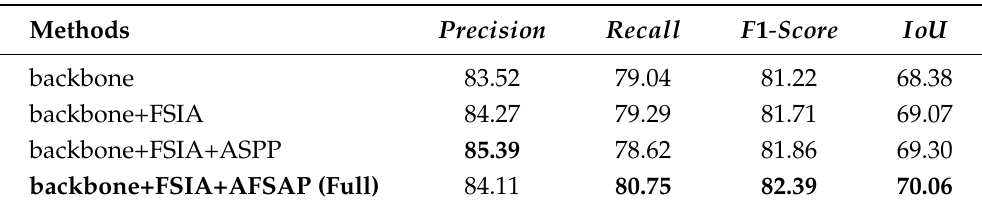
Table 4. Ablation results on Precision , Recall , F 1- Score , and IoU (in %) of our proposed FSIANet on the East Asia Dataset. The best results are shown in bold.